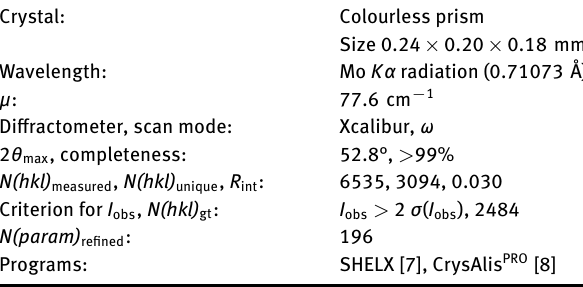
Table 1: Data collection and